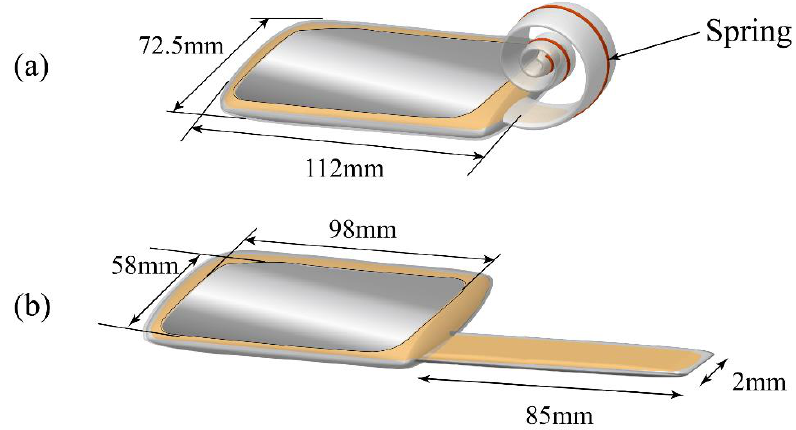
Figure 5. The physical dimensions of the proboscis actuator for ( a ) coiling and ( b ) uncoiling states, where the dimensions of the pouch and tube are 112 mm × 72.5 mm and 85 mm × 2 mm, respectively. The area size of the electrodes is 98 mm × 58 mm.